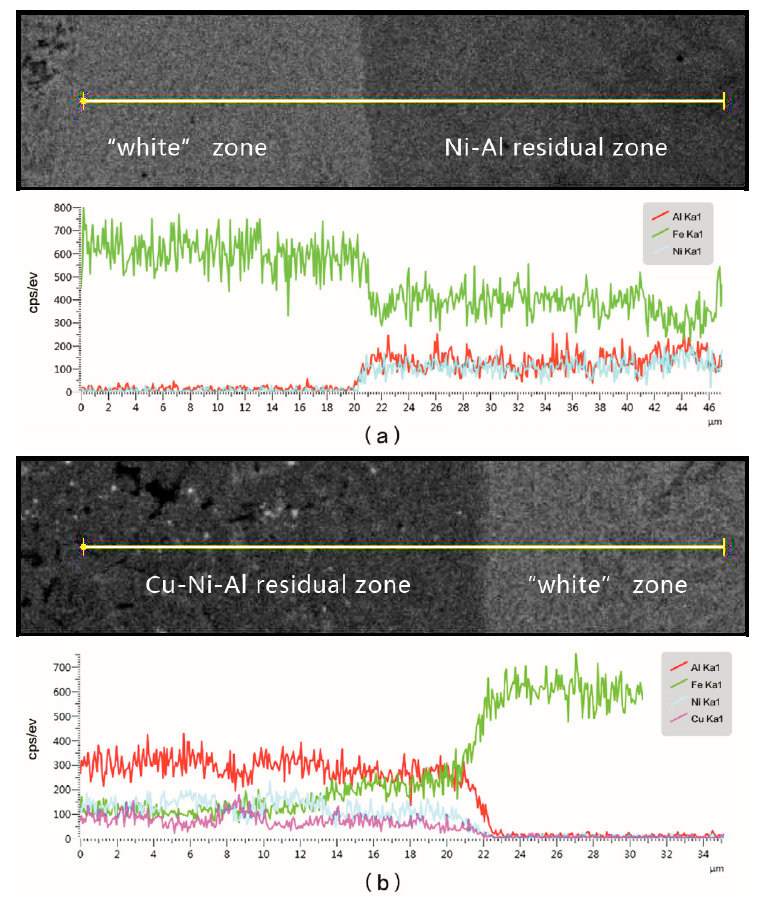
Figure 9. The point EDS results of Ni-Al and Cu-Ni-Al residual jet zone.